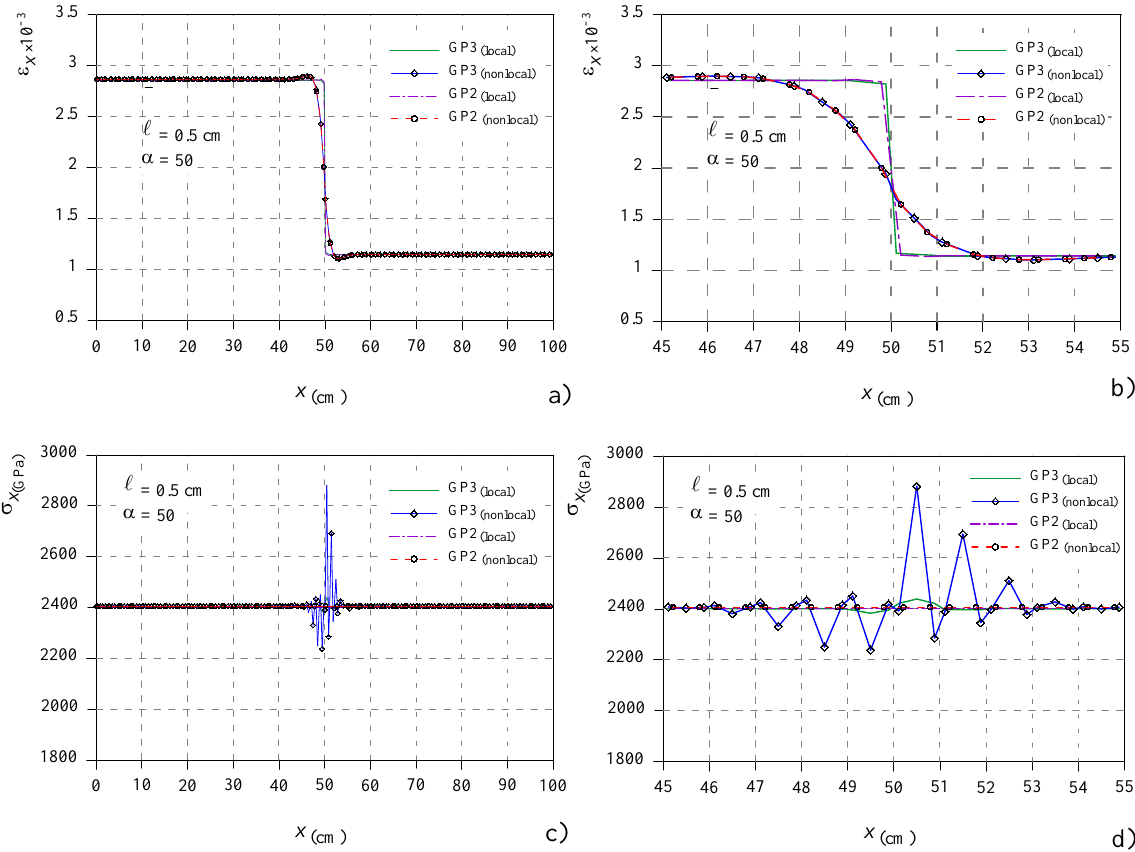
Figure 3: Local and nonlocal solution obtained with full (GP3 curves) and reduced (GP2 curves) integration for the bar of Figure 1 with inter- nal length ℓ = 0.5 : a ) and b ) strain ε